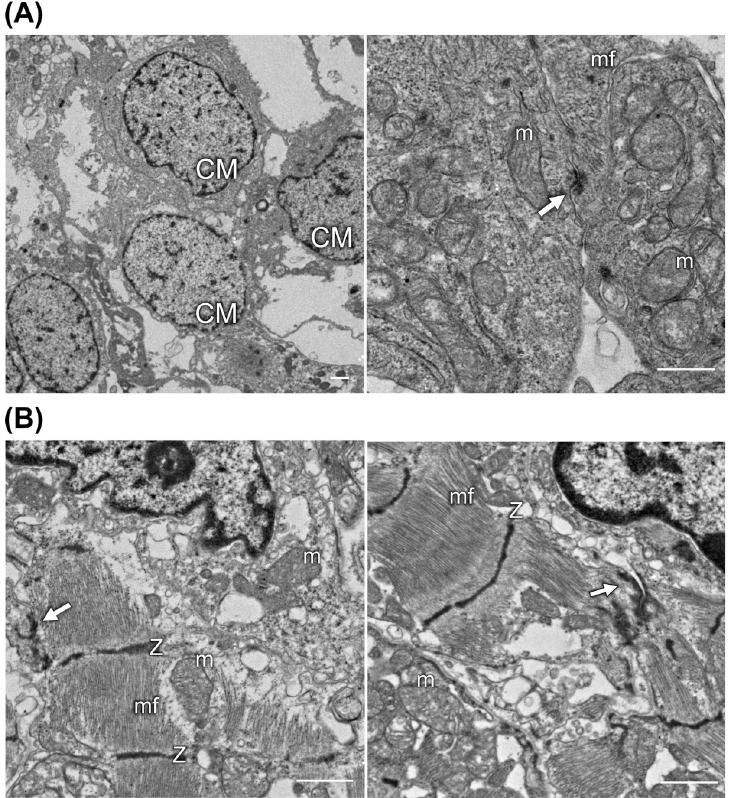
Fig 5. Ultrastructural analysis of 3D-hiPSC-CT using transmission electron microscopy (TEM). (A) TEM images of 3D-hiPSC-CT in vitro . The hiPSC-CM (CM) are assembled to be in contact with each other via desmosomes (white arrow). A few myofibrils (mf) and mitochondria (m) are observed within the cardiomyocytes, scale bar = 1 μ m. (B) TEM images of 3D-hiPSC-CT in vivo . The 3D-hiPS-CT showed clear thickened myofibrils (mf), Z-band (Z), and mitochondria (m). The adherens junction (black arrow) and desmosome (white arrow) were also disclosed between the iPSC-CM, scale bar = 1 μ m.